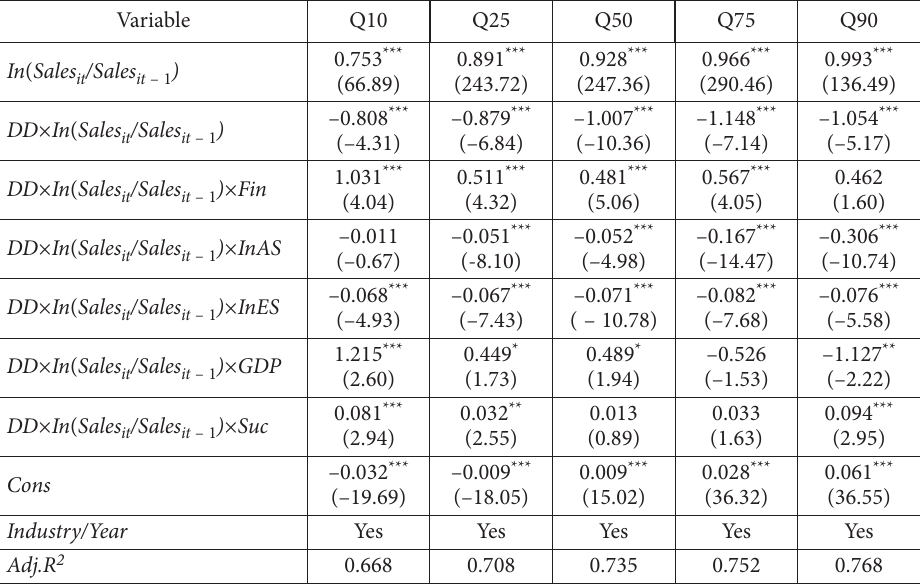
Table 3. Quantile regression